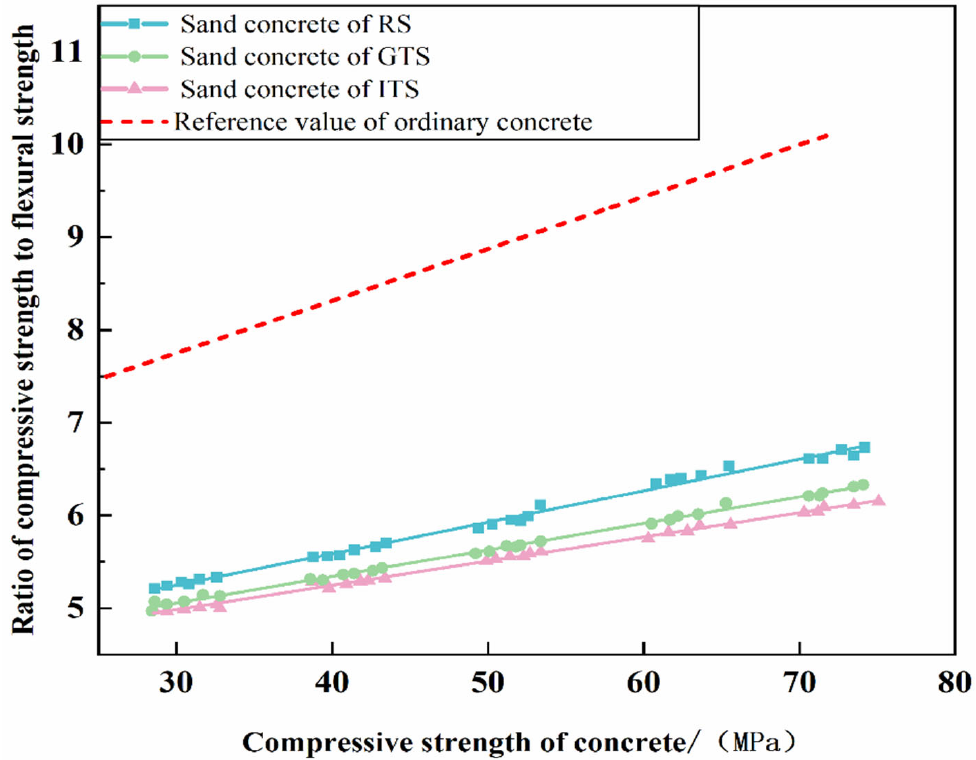
Figure 8. The ratio of compressive strength to flexural strength with sand concrete.